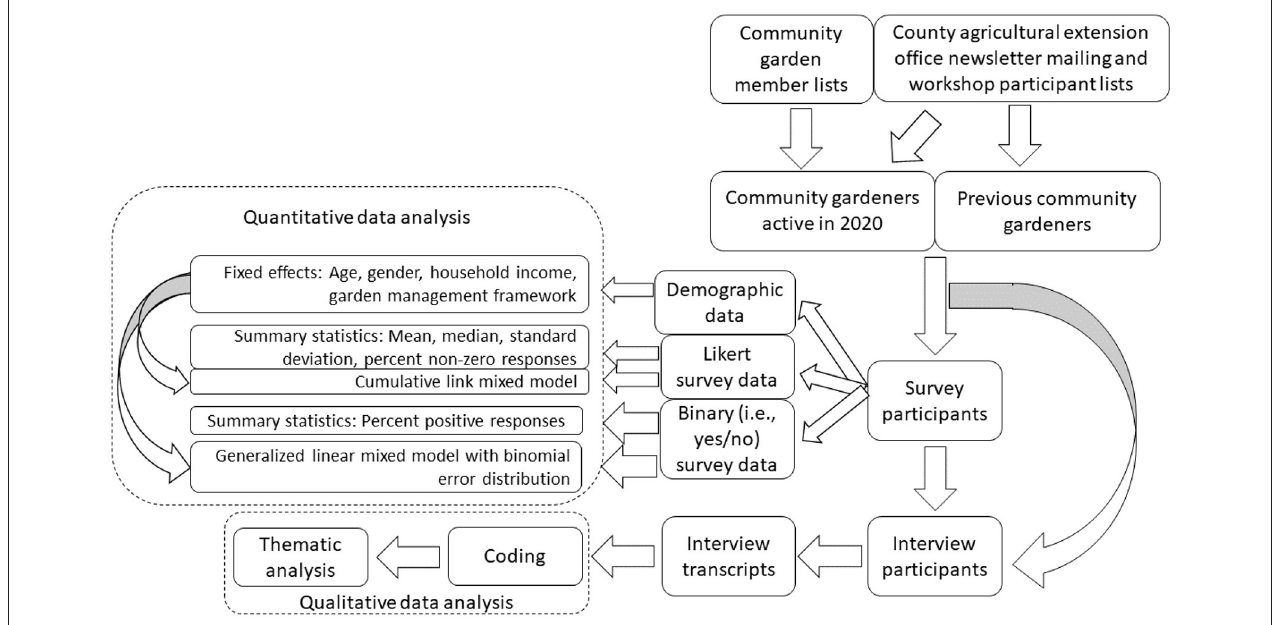
FIGURE 1 | Framework for convergent mixed methods of data collection and analysis.